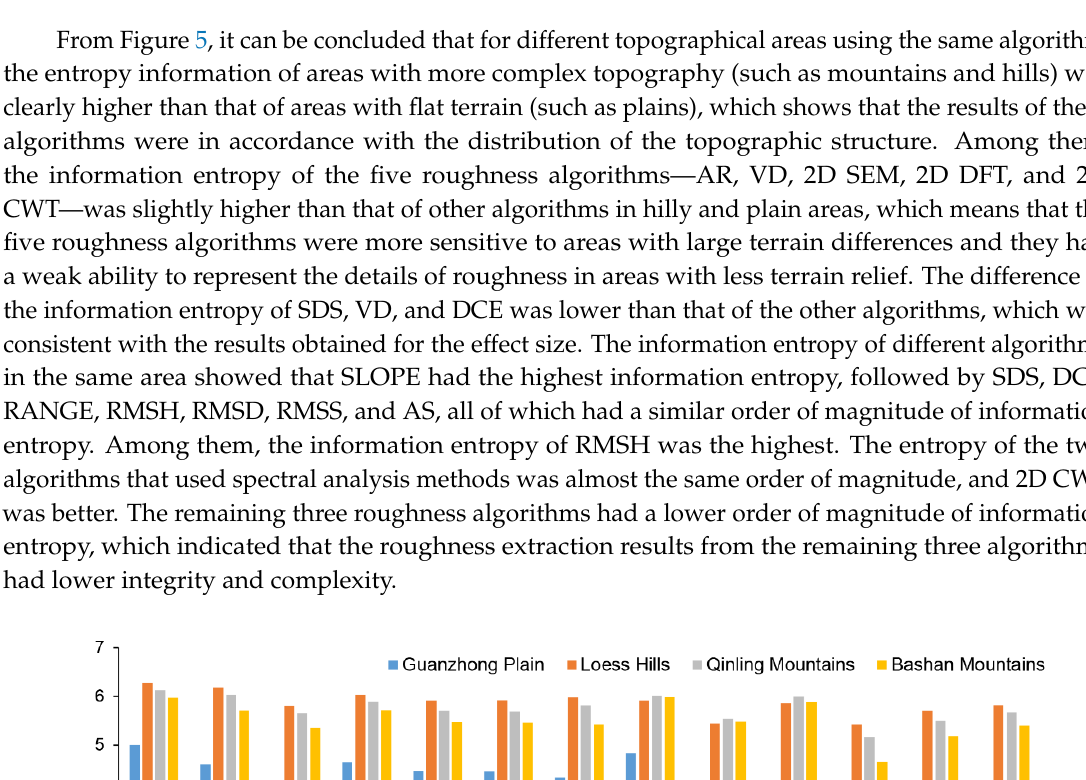
Figure 4. Comparison of the effect sizes between different roughness algorithms in different regions.